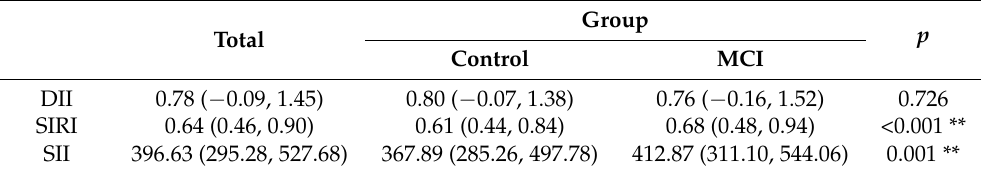
Table 2. Dietary and blood inflammatory index overall and by MCI.